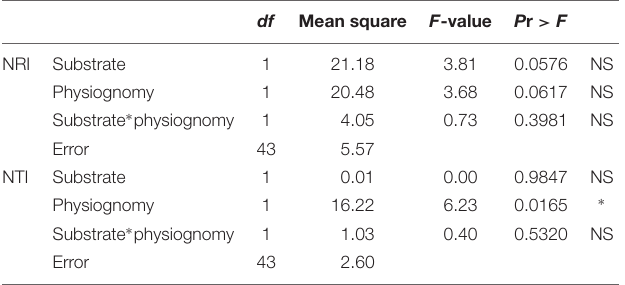
TABLE 3 | Results of ANOVA to evaluate relative contribution of substrate, physiognomy and interactions of substrate and physiognomy to explaining variation in NRI and